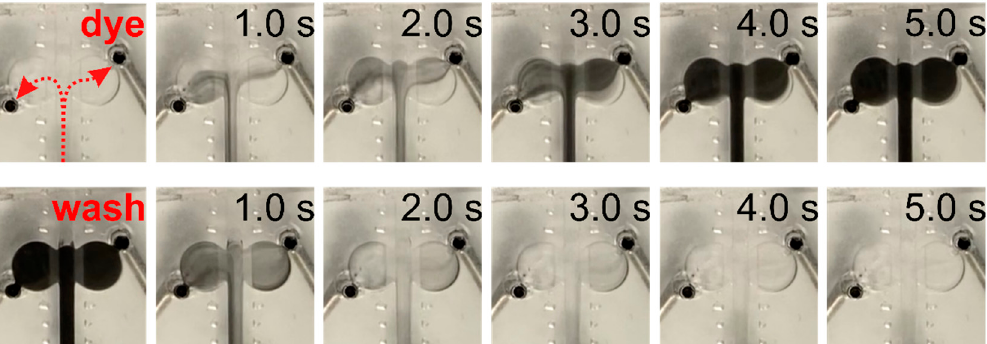
Figure 4. In the chip setup application insert assembly provides gradual turbulence-free substitution of liquid (dye application depicted, red arrows indicate flow direction). For details of the chip design and chip-based setup see Appendix A, Figures A1 and A2.